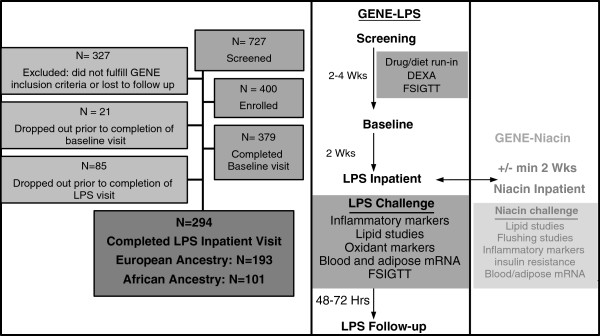
Design of the genetics of evoked responses to niacin and endotoxemia study. Healthy volunteers of European and African ancestry participated in the Genetics of Evoked Responses to Niacin and Endotoxemia (GENE) Study. Results are presented here for the 294 individuals that participated in the GENE-LPS component of the study.